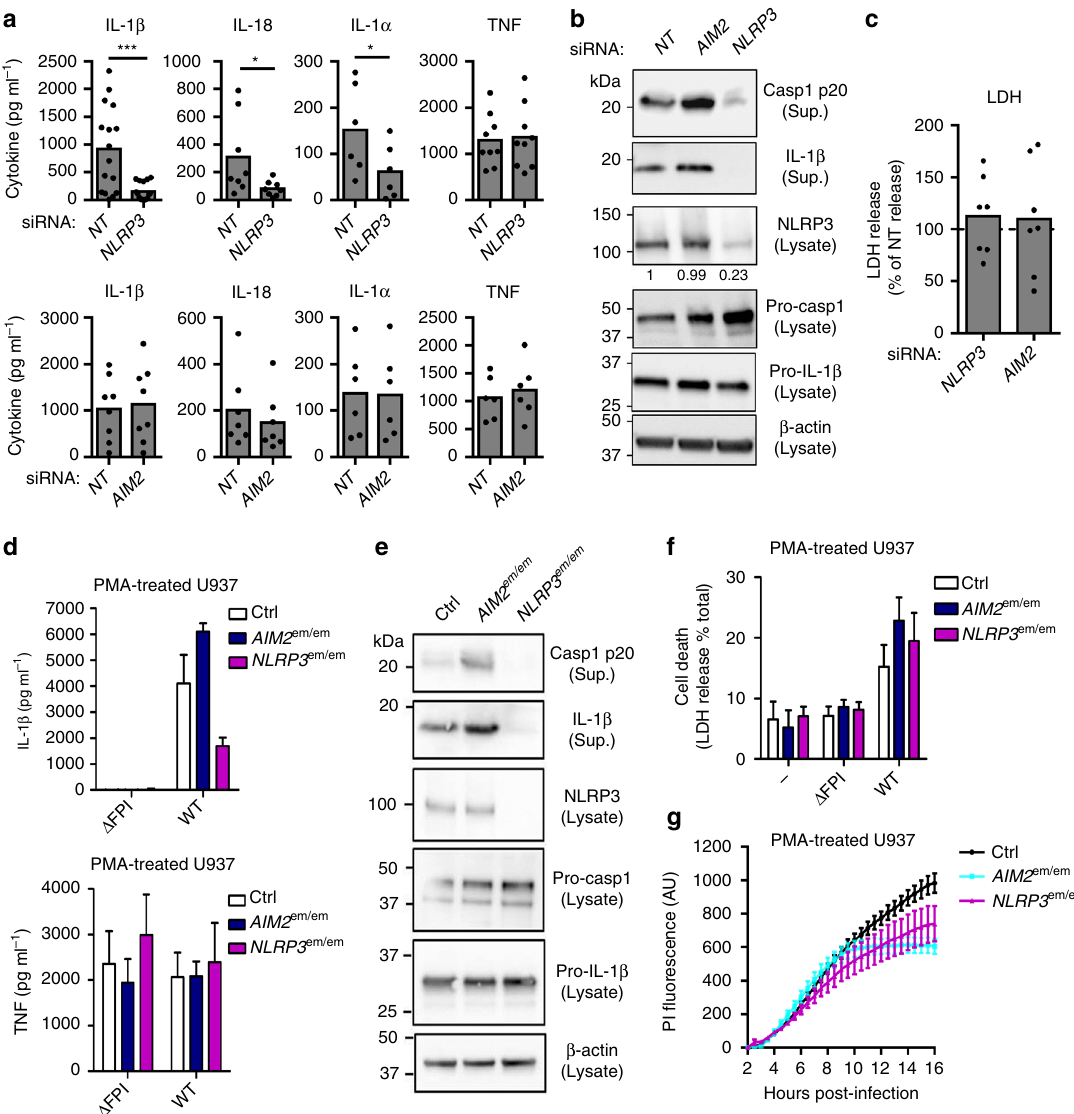
Fig. 2 NLRP3 is required for F . novicida -mediated in fl ammasome activation in the cytosol of hMDMs. a – c hMDMs were transfected with non-targeting (NT) siRNA or with the indicated siRNA and infected with F . novicida at a multiplicity of infection (MOI) of 10 for 6 h (IL-1 β , TNF and lactate dehydrogenase (LDH)) or 8 h (IL-18 and IL-1 α , Western blot). a IL-1 β , IL-18, IL-1 α , and TNF levels were quanti fi ed by ELISA. b NLRP3, Caspase-1, and IL-1 β protein level and processing were evaluated in the supernatant (Sup.) and the lysate of infected hMDMs. c Cell death was assessed by measuring LDH release. d – g IFN- γ - treated, phorbol 12-myristate 13-acetate- (PMA) differentiated control (Ctrl) U937 and U937 cell lines generated using CRISPR/Cas9 endonuclease- mediated (em) invalidation were infected with F . novicida at a MOI of 100 and monitored for d IL-1 β and TNF release at 6 h post-infection or cell death by measuring f LDH release at 6 h post-infection and g propidium iodide (PI) incorporation/ fl uorescence in real-time (AU arbitrary units). e NLRP3 protein levels, caspase-1 and IL-1 β processing were evaluated as indicated in the lysate and/or the supernatant (Sup.) of U937 cells infected for 8 h. a , c Each point shows the mean value from three technical replicates for one healthy donor, the bar shows the mean value for all donors ( n ≥ 6). Two-tailed p values with the following nomenclature (*** p < 0.001 and * p < 0.05 by paired t -test) are shown. b , e One experiment representative of two independent experiments is shown. c For each healthy donor, the mean value from cells transfected with NT siRNA was used as a reference value set to 100%. d , f Mean values ± standard deviation (SD) from three independent experiments are shown. g Mean values ± SD from three technical replicates from one experiment representative of three independent experiments are